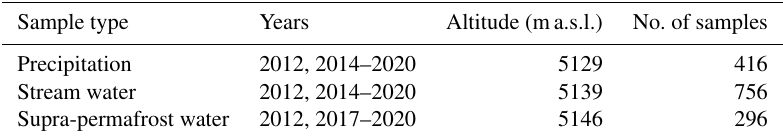
Table 2. Information of samples and sampling